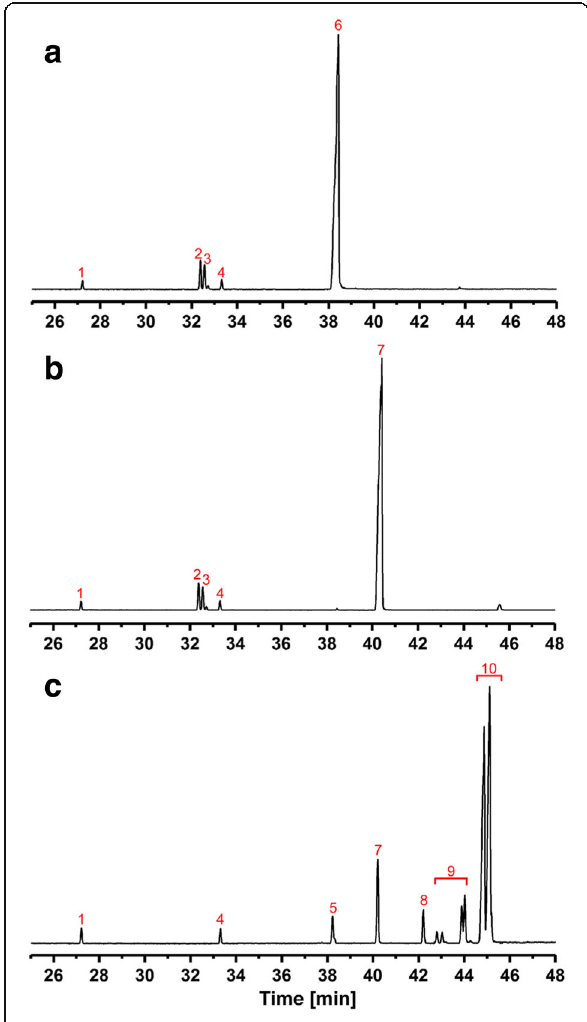
Fig. 3 Gas chromatograms of a MR, b MRA, and c EMRA